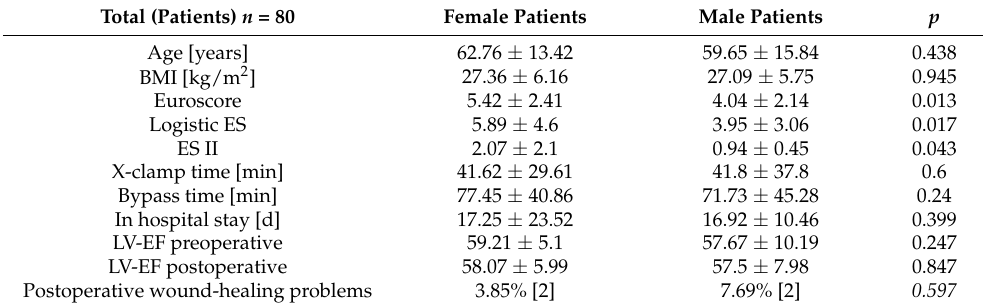
BMI: body mass index; LV-EF: left ventricular ejection fraction; ES II: EuroSCORE II.